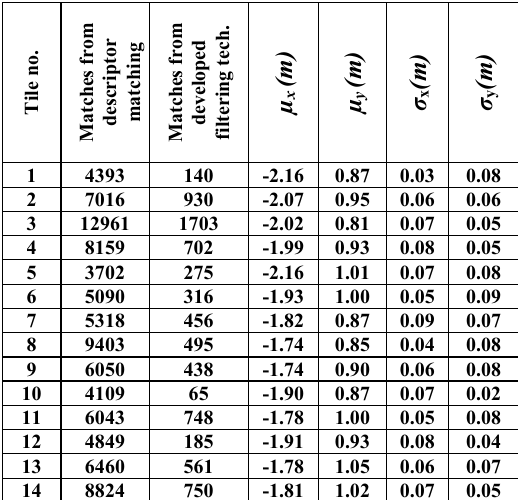
Table 2: Number of Matched keypoints and the normal probability function parameters of translation (all units are in meters) for each tile 2